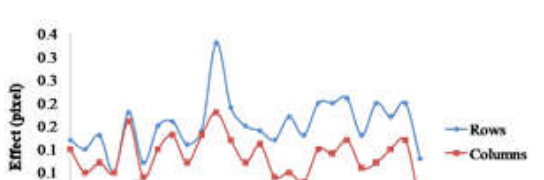
Figure 8. (a) Effect of symmetrical radial distortion with the coefficients of each band for a point in the image corner; (b) Effects of symmetrical radial distortion with the coefficients of a reference band and changing the focal length; (c) differences from the two effects.